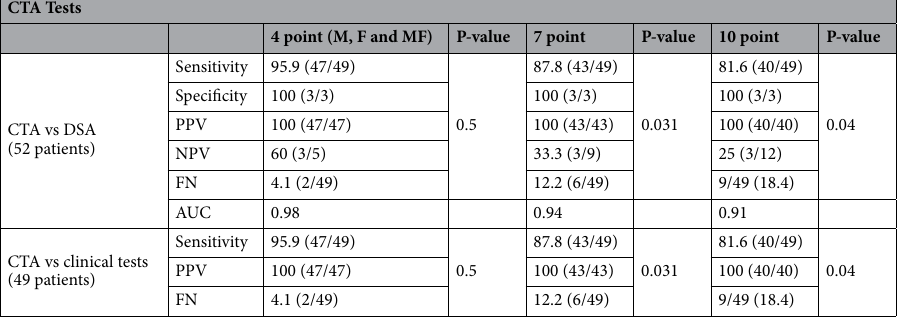
Table 2. Comparison of different computed tomography angiography tests (CTA) to digital subtraction angiography (DSA) in the determination of brain death. Sensitivity, specificity, positive predictive value (PPV), negative predictive value (NPV) and false negative (FN) results along with area under the curve (AUC) of different CTA tests (computed tomography angiography) for determination of brain death in comparison to DSA (Digital Subtraction Angiography) and clinical tests. Data are presented as percentages (%) and patients count for sensitivity, specificity, PPV, NPV and FN and area for AUC curve. All comparisons among ancillary imaging tests (CTA tests and DSA or CTA and Clinical tests) for the diagnosis of brain death revealed statistical significance (p < 0.001, Cochran’s Q test). P-value indicates differences between CTA-4 point (M, F and MF), CTA-7 point and CTA-10 point compared to DSA and clinical tests (McNemar’s